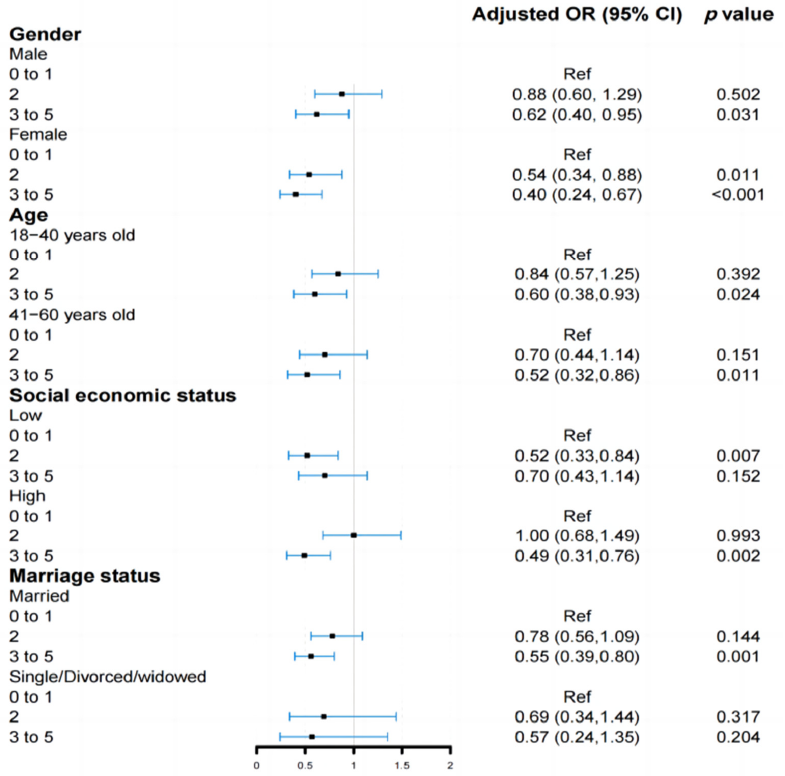
Figure 3. Stratification analyses of the association between healthy lifestyle scores and NAFLD. OR, odds ratio; CI, confidence interval.